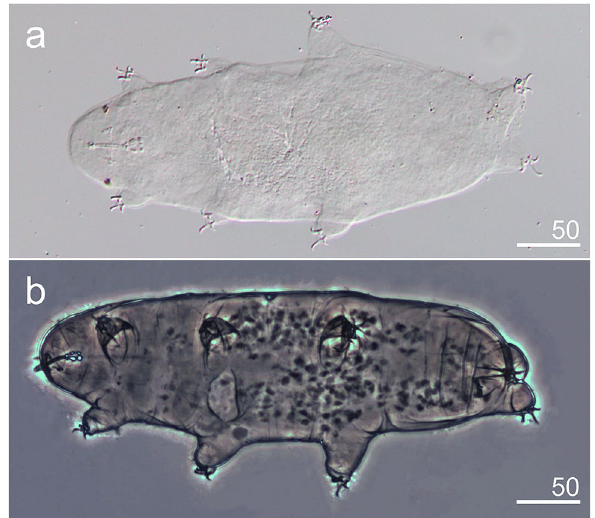
Figure 7. Hypsibius sp. from Mt. Gassan, habitus: ( a ) ventral view (DIC), ( b ) ventrolateral view